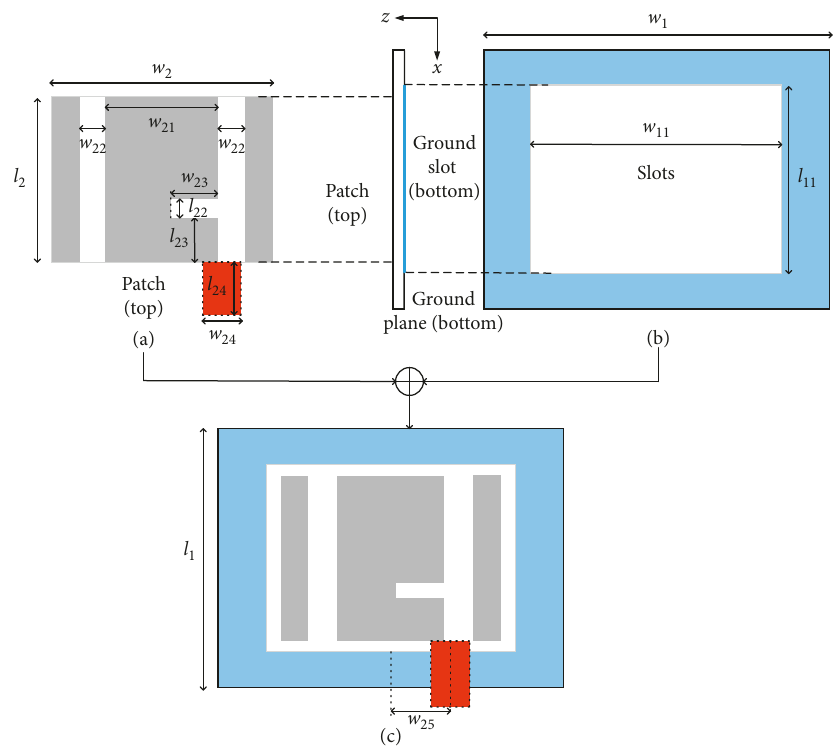
Figure 1: The geometries of the proposed CP antenna.